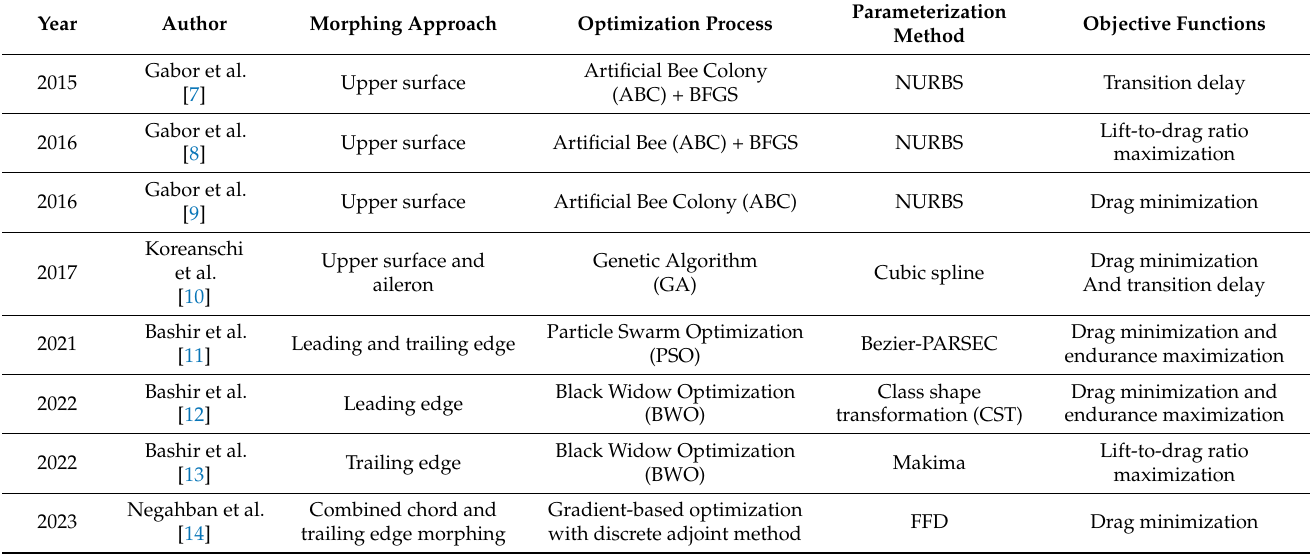
Table 1. List of research conducted on at LARCASE using different optimization algorithms and parametrization